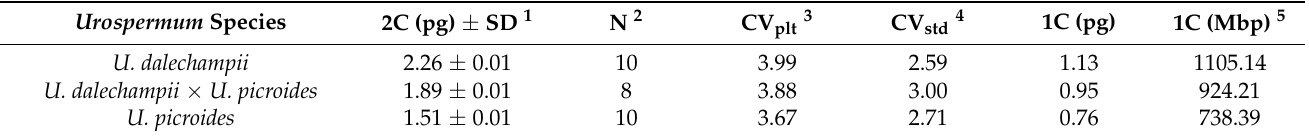
Table 2. Genome size data for Urospermum dalechampii , U. dalechampii × U. picroides and U. picroides at Montjuïc (Catalonia, Spain).